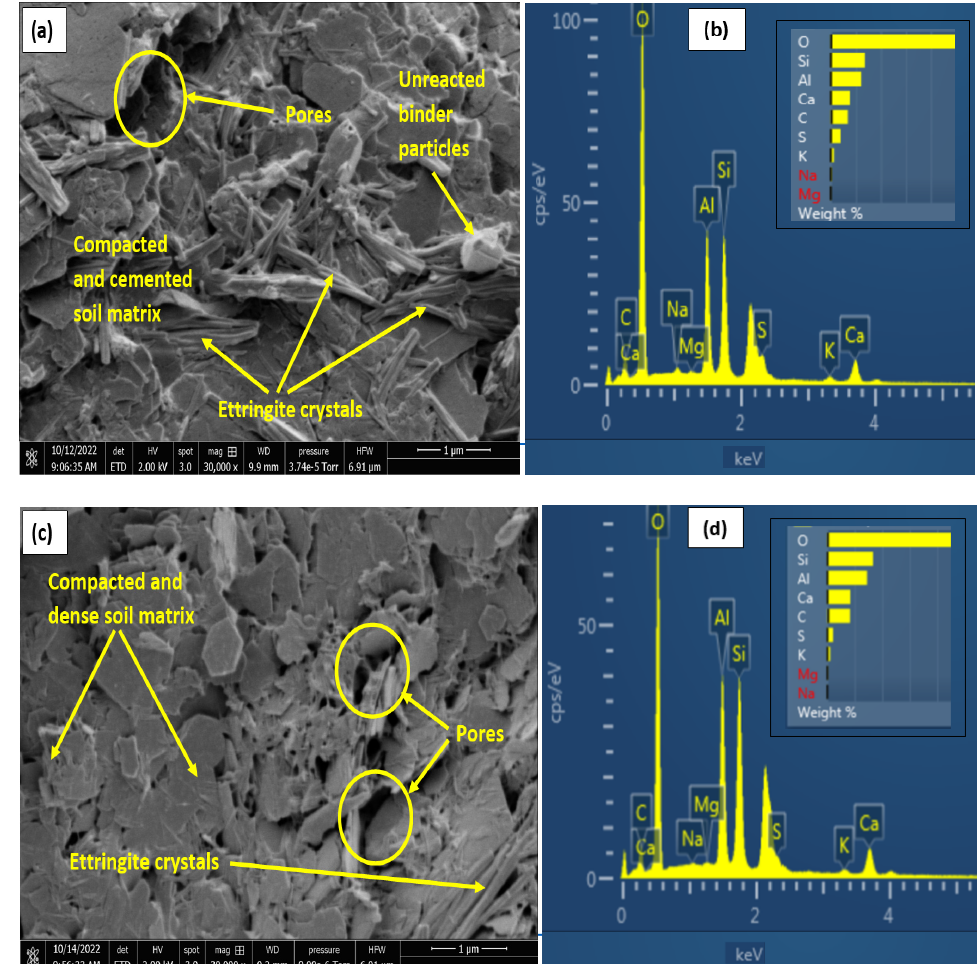
Figure 13. SEM and EDX results of 28-days cured LGGBS-treated gypseous samples. ( a ) SEM of 15%Gypseous soil. ( b ) EDX of 15%Gypseous soil. ( c ) SEM of 35%Gypseous soil. ( d ) EDX of 35%Gyp- seous soil.